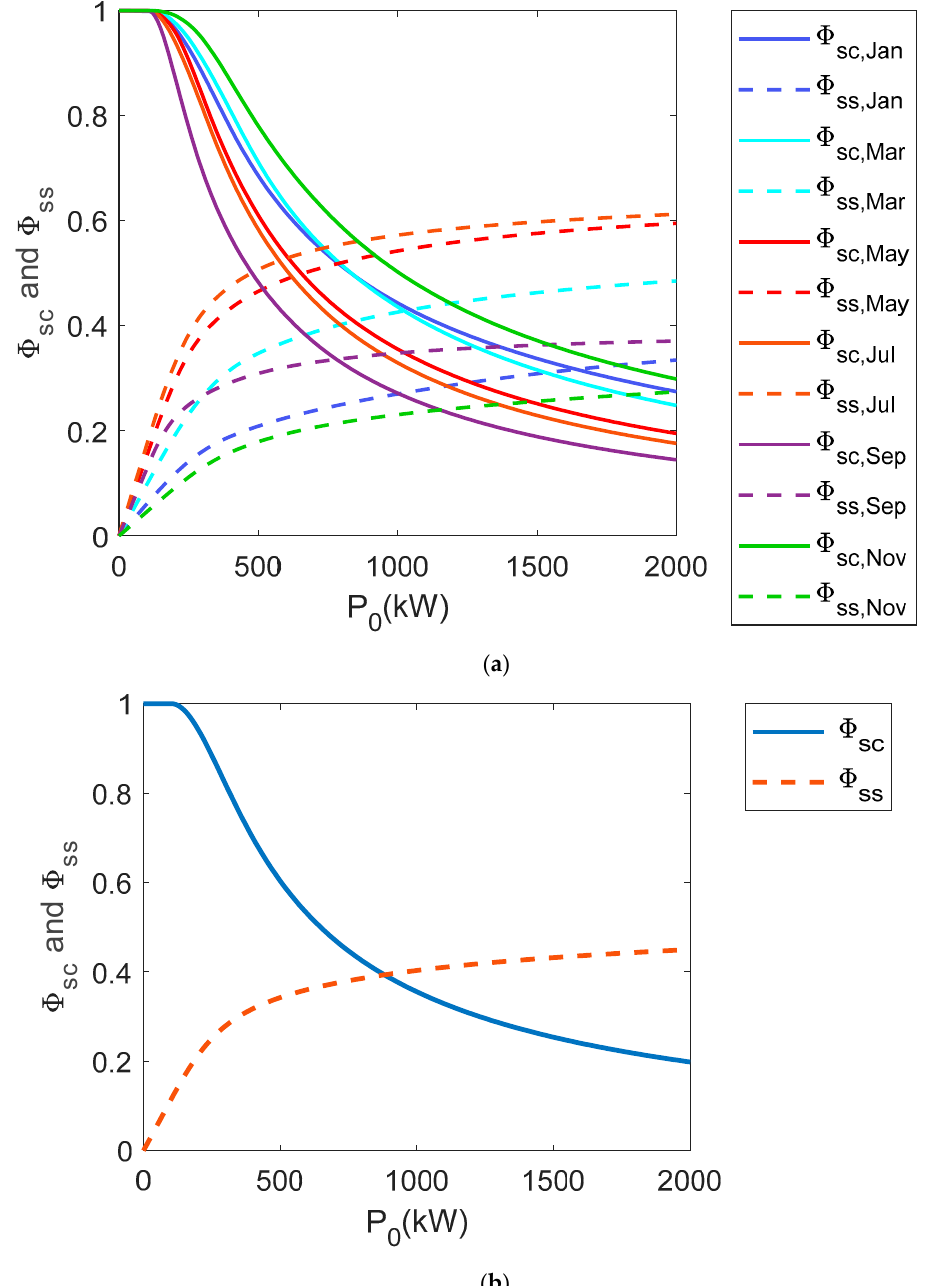
Figure 9. ( a ) Monthly self-consumption and self-sufficiency curves; ( b ) Annual self-consumption and self-sufficiency curves. Industry B.